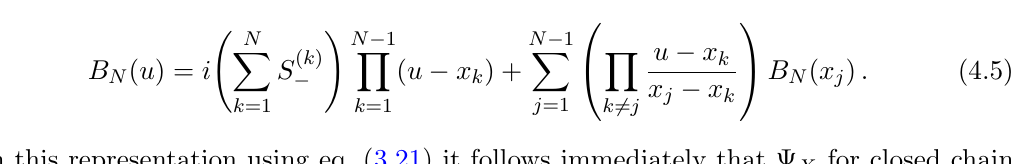
ix k and (cid:12) k = s + ix k (cid:0)